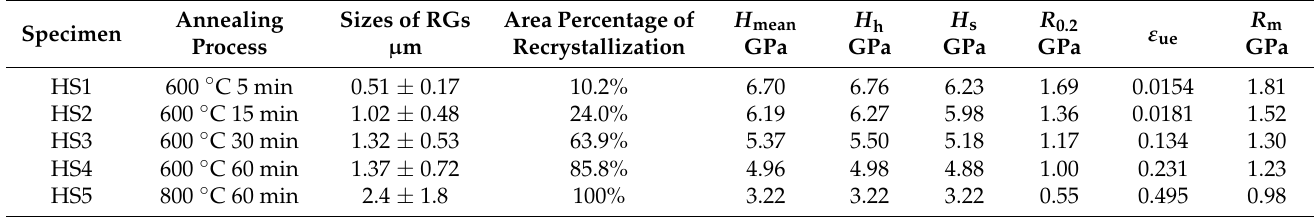
Figure 2. EBSD maps of the TD direction of the specimens with different levels of heterogeneity. From left to right are the HS1 to HS5 samples, respectively. ( a ) KAM maps. ( b ) Orientation maps. ( c ) Statistical diagrams of the sizes of the RGs. ( d ) Pattern quality maps of the TD direction of the specimens, with parts of the indentations. Table 1. The statistical results of the microstructures and mechanical